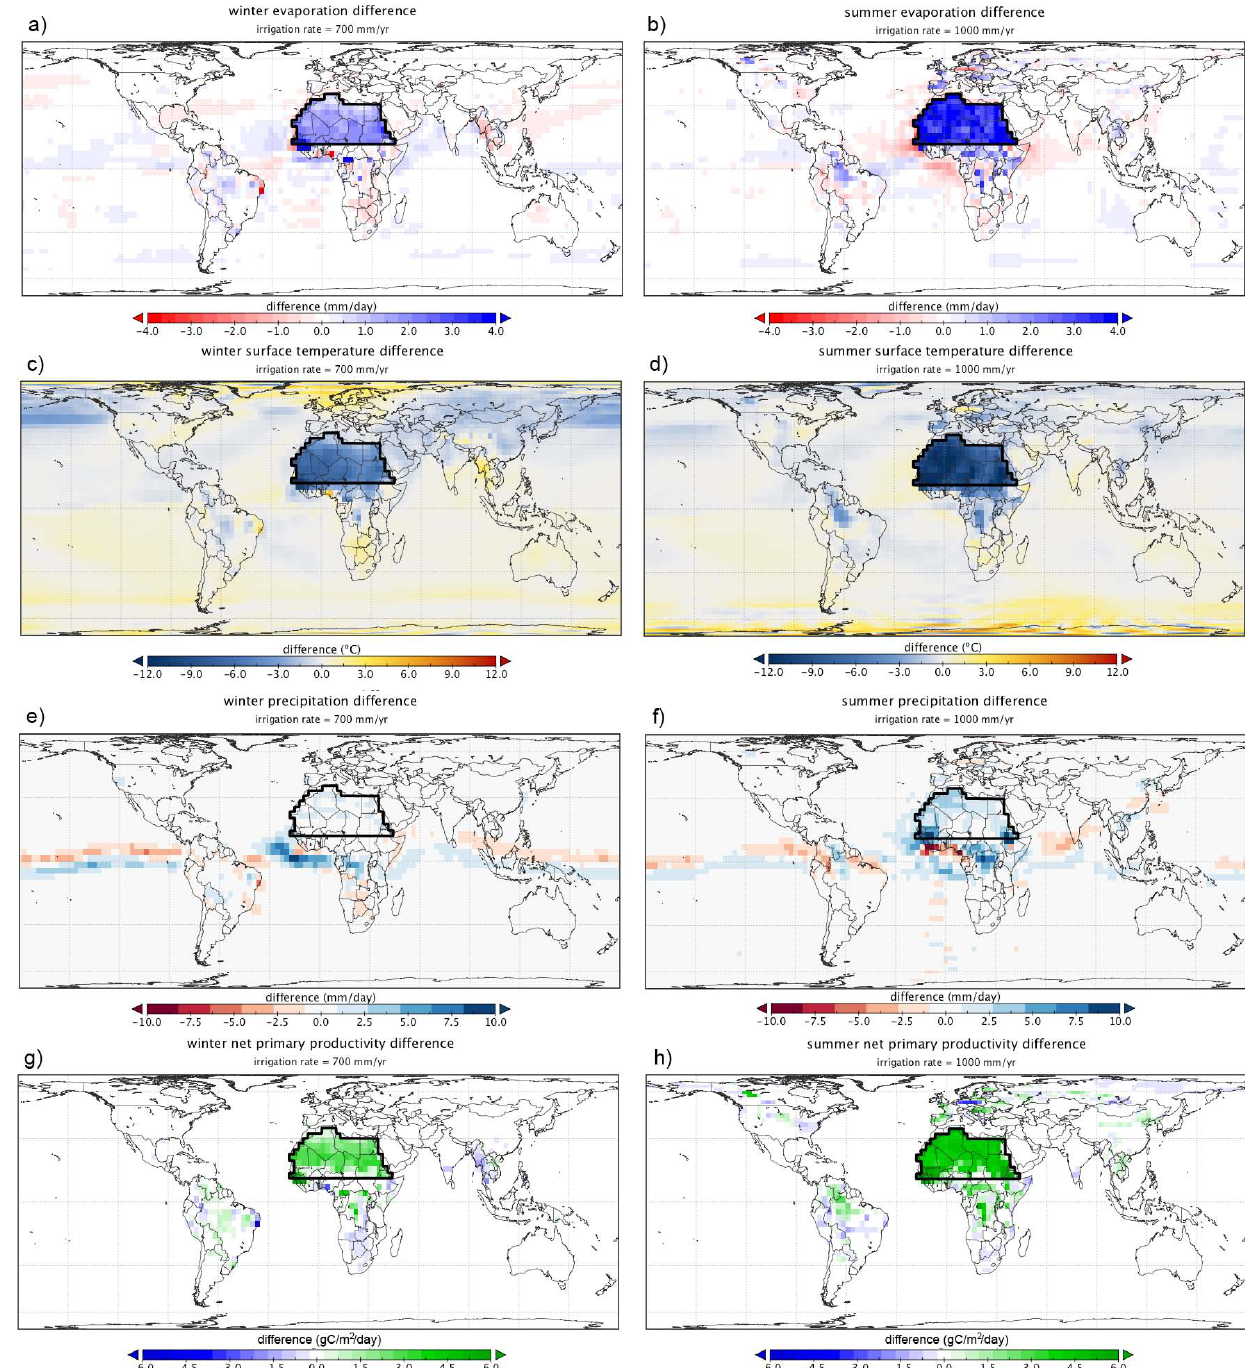
Fig. 4. Differences in evaporation (a, b) , surface temperature (c, d) , precipitation (e, f) , and net primary productivity, or NPP (g, h) during winter (left panels) and summer (right panels); winter compares the 700mmyr − 1 and control simulations for December–February, while summer compares the 1000mmyr − 1 and control simulations for June–August, with the black solid line bounding the Sahara/Sahel identi- fying the irrigated region. Note the significant differences in both variables in regions outside the irrigated region, particularly in southern Africa, southern Europe and northern Latin America. The corresponding southward shift in the inter-tropical convergence zone (ITCZ) is clearly visible in both winter (e) and summer (f)